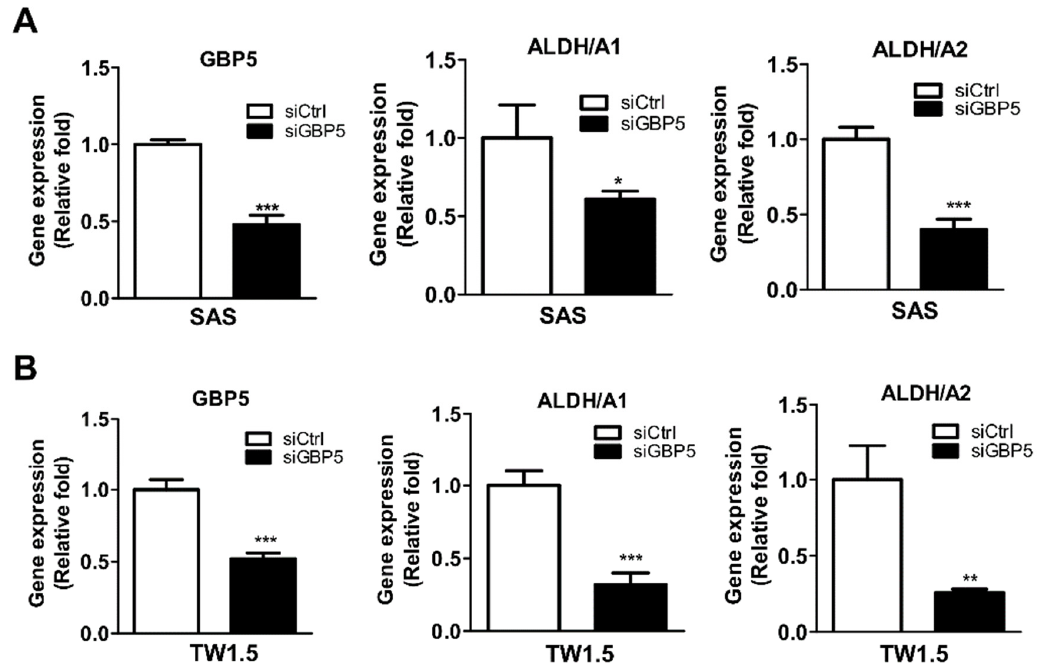
Figure 5. Effects of GBP5 in cancer stemness of OSCC cells. Gene expression levels of cancer stemness-related markers in GBP5-silenced ( A ) SAS and ( B ) TW1.5 cells by RT-PCR. All cells were transiently transfected with 10 nM scramble siRNA (siCtrl) or GBP5 siRNA (siGBP5) for 72 h. All quantitative results are calculated as the mean ± SEM from three independent experiments. A value of p < 0.05 was considered significant (*** p < 0.001, ** p < 0.01, * p < 0.05). Table 4. The co-expression of GBP5 and cancer stemness markers in overall survival of oral cancer patients from TCGA database.